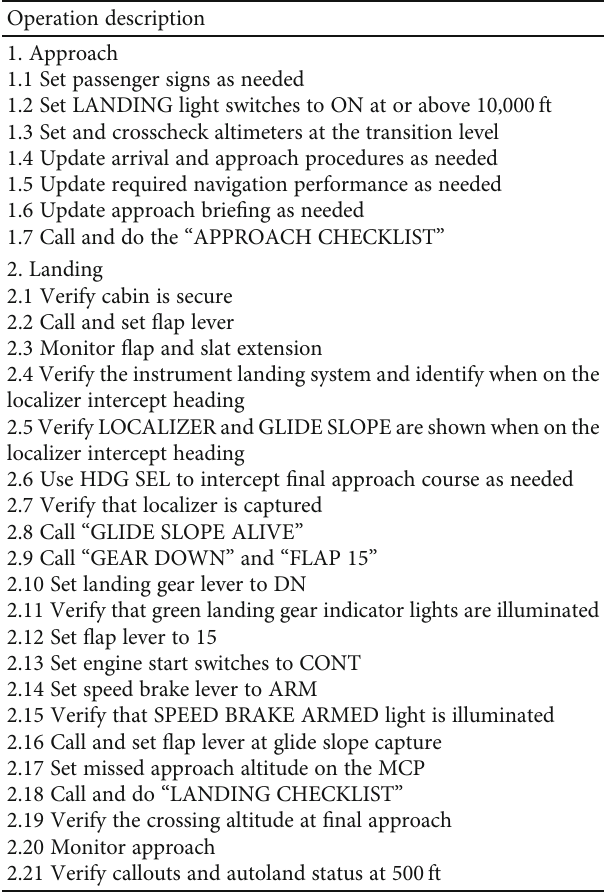
Table 6: Operations in the approach and landing